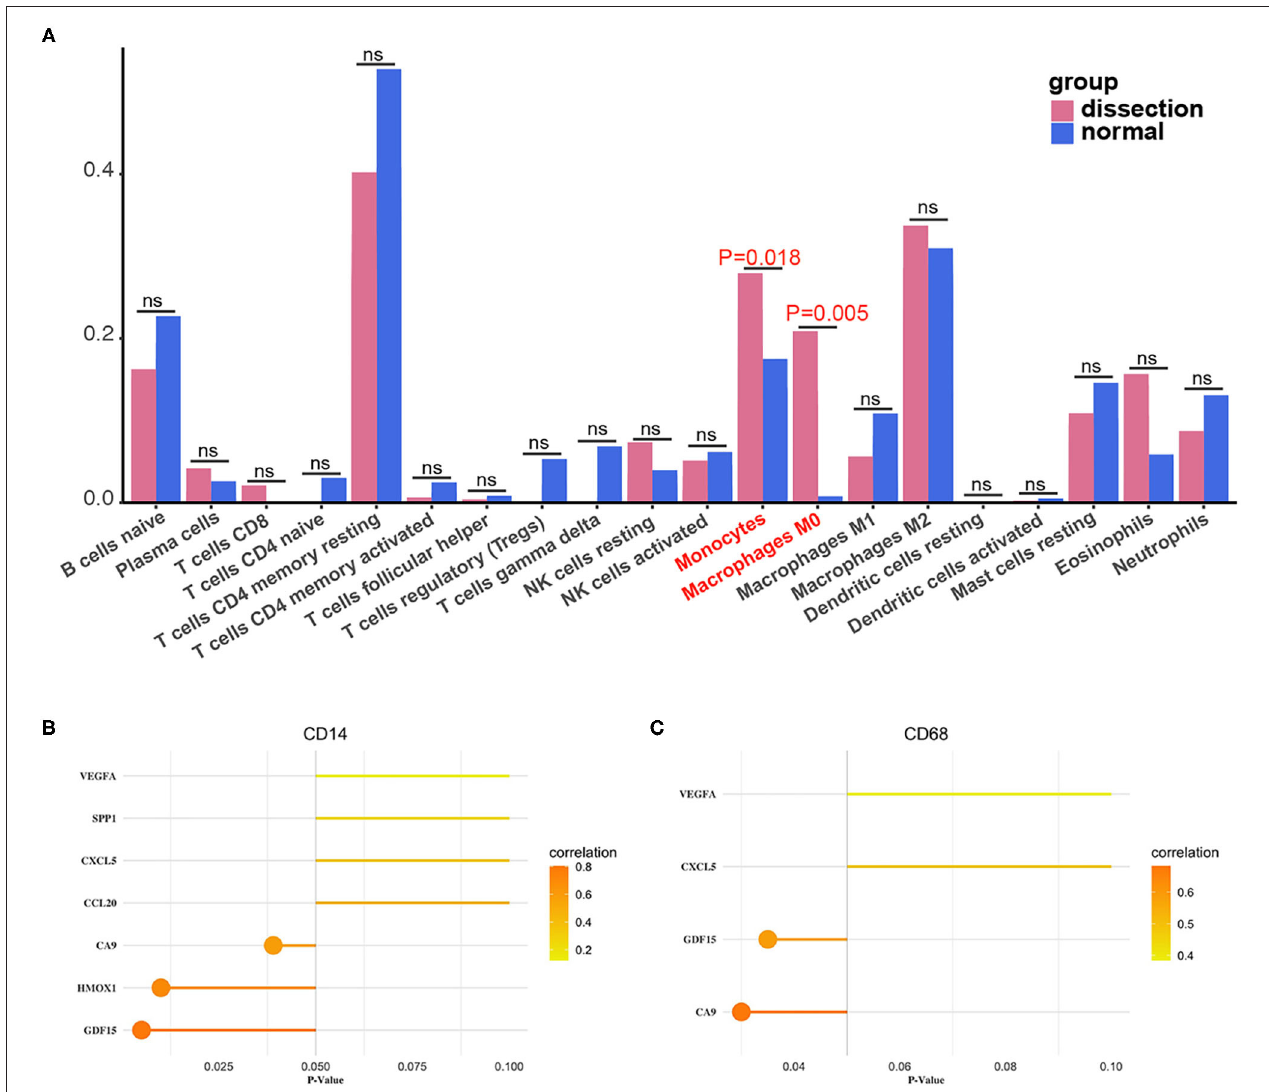
FIGURE 9 | Validation of immune infiltration and correlation analysis. (A) The histogram of the fraction of immune cells in the validation set. Red indicates the AAD samples, and blue indicates the non-AAD samples. The Wilcoxon test was performed, and the results showed a significant difference in the fraction of immune cells between AAD samples and non-AAD samples, which was in accordance with results from the training set. (B,C) Analysis of the correlation between immune cells and hub genes in the validation set with Pearson